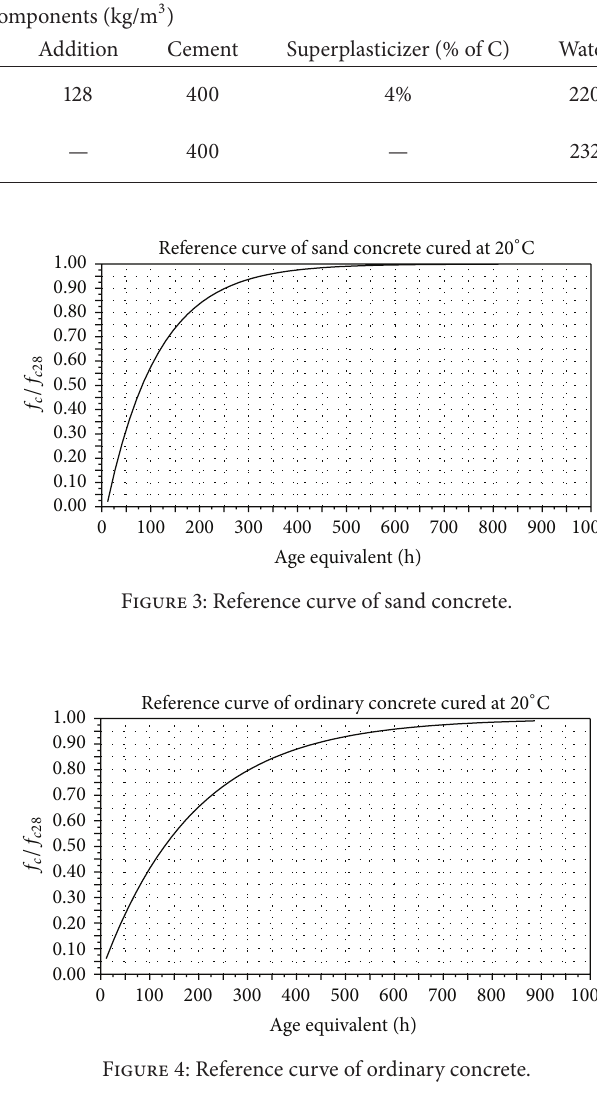
Table 2: Mixes of sand and ordinary concrete.